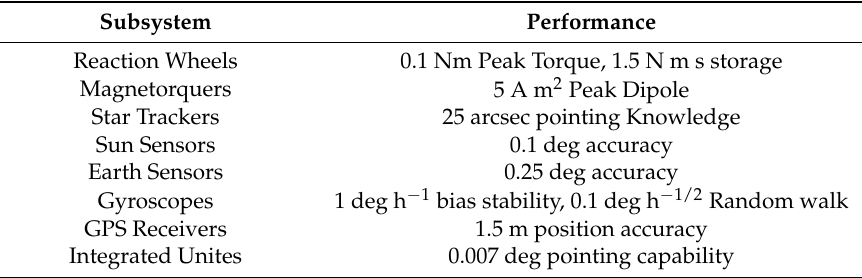
Figure 33. AD&C System Algorithm Architecture [49]. Table 14. Typically, Implemented Guidance, Control, and Navigation Technologies [23].